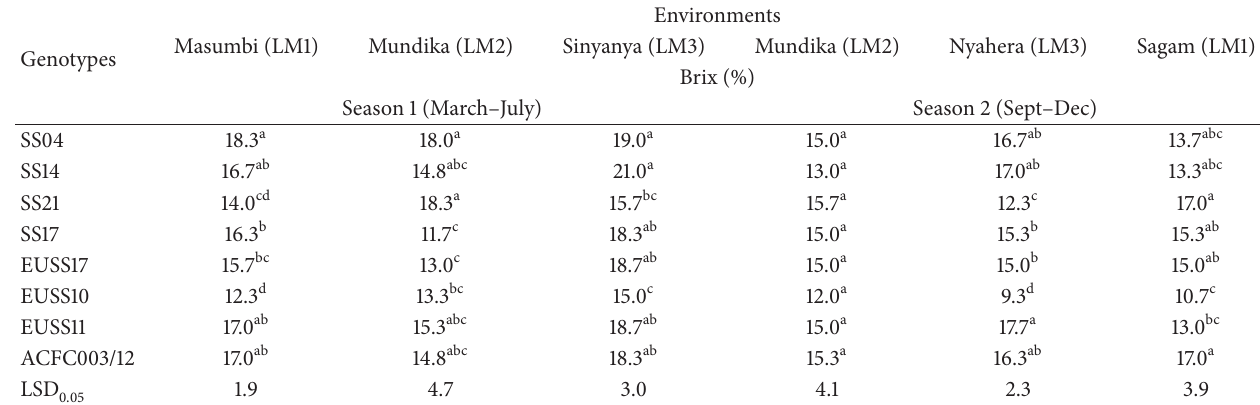
Table 6: Brix (%) of sweet sorghum genotypes across environments.